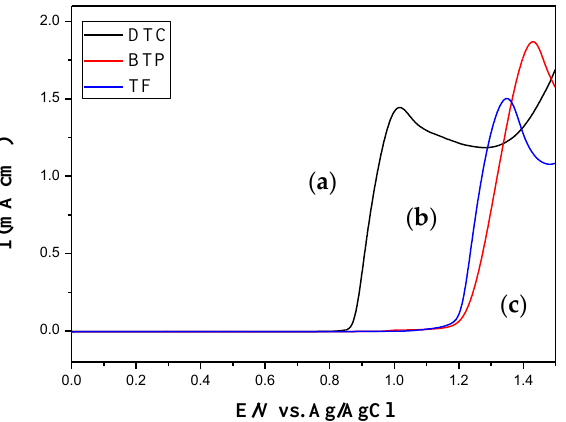
Figure 1. Electrooxidation curves of ( a ) 2 mM DTC, ( b ) 2 mM BTP, and ( c ) 2 mM TF in 0.2 M LiClO 4 /acetonitrile (ACN) at a scan rate of 100 mV s −1 .